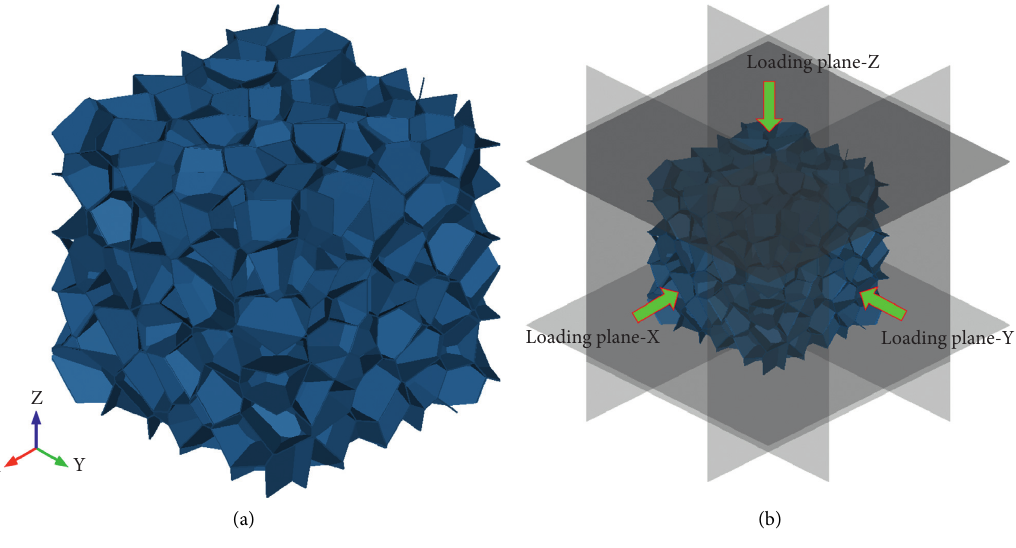
Figure 9: Finite element model (a) and loading method (b) .